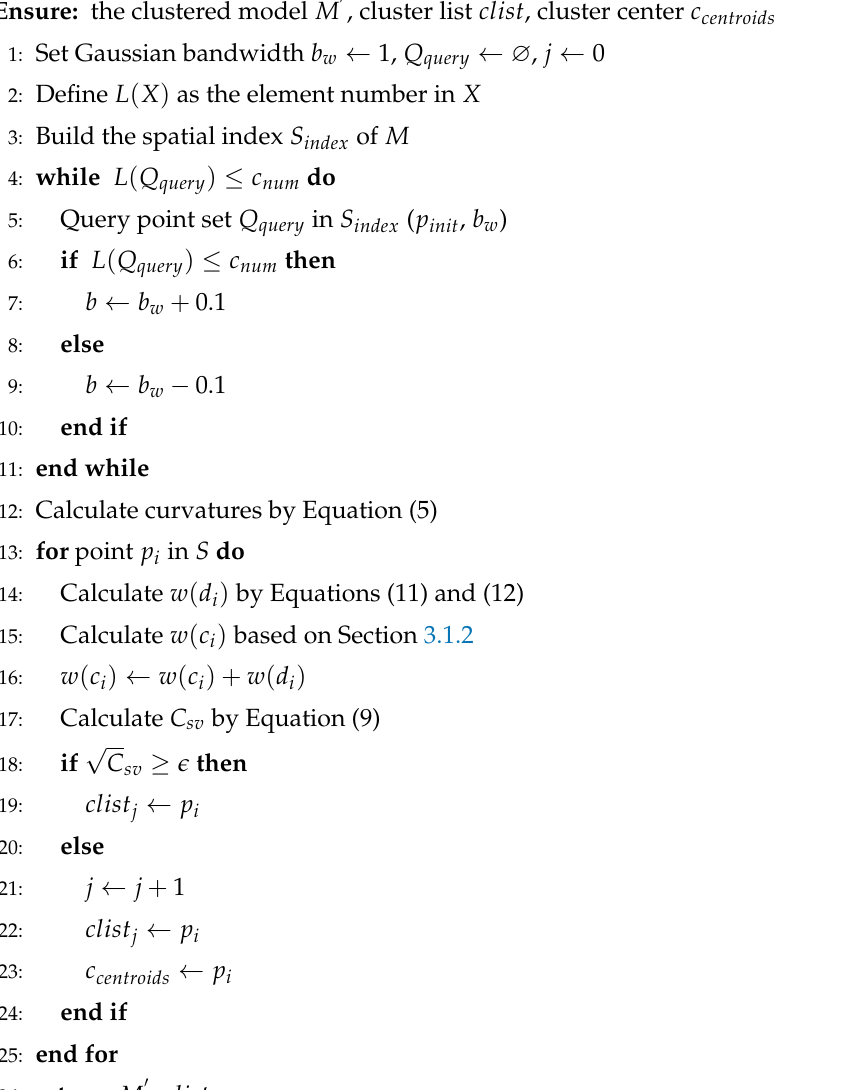
Algorithm 1 Curvature